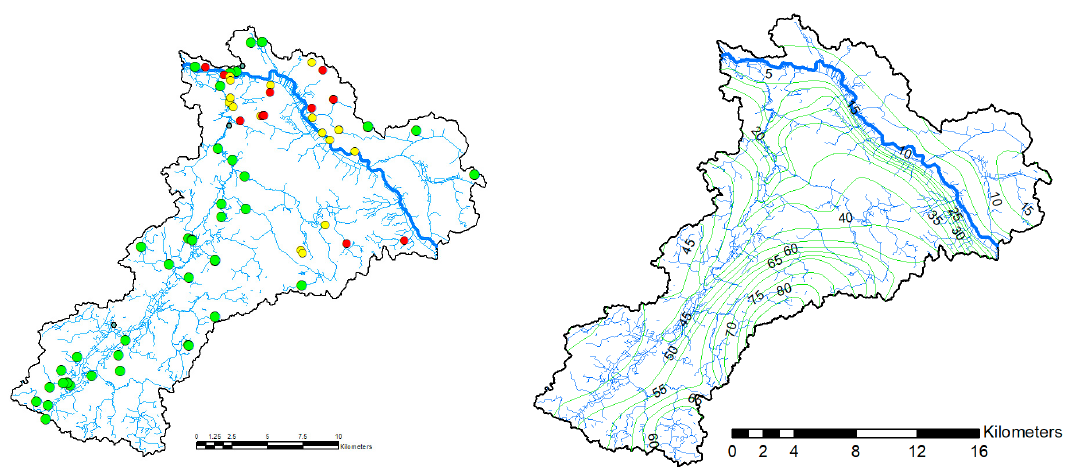
Figure 3. ( left ) Summary of the available boreholes and their functionality status in the study area, where green circles are the boreholes found and working; yellow circles are the boreholes found but not working; and red circles are the boreholes not found; ( right ) constructed groundwater contours in study area.